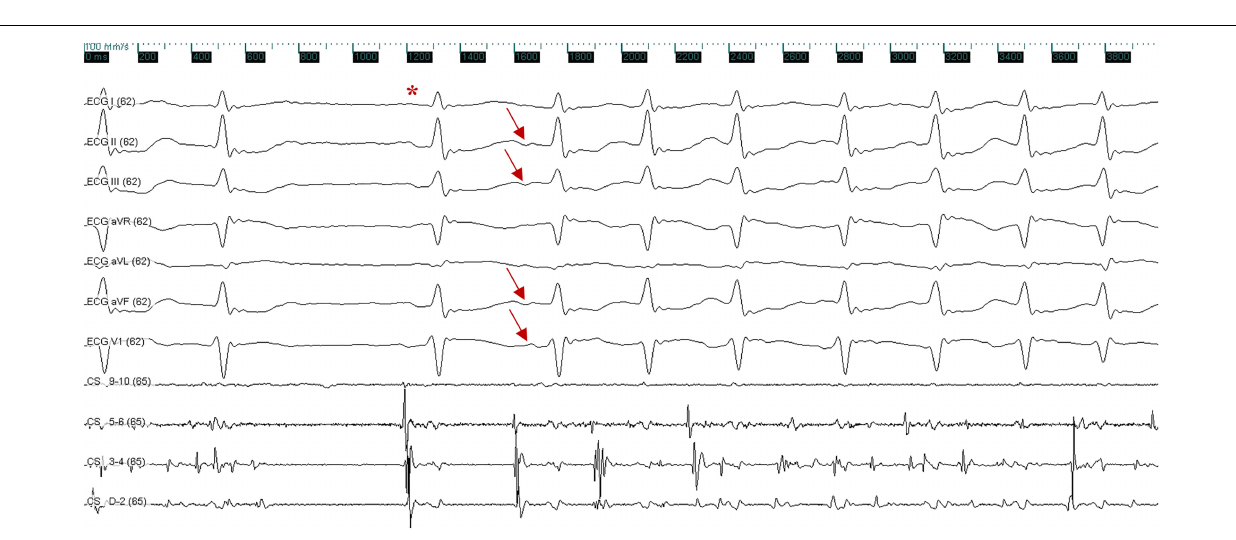
FIGURE 2 | Surface and intracardiac electrocardiogram indicate the termination of atrial fibrillation, followed by a sinus beat (red asterisk); atrial fibrillation was triggered again by a premature atrial complex, which exhibited a negative P wave in inferior leads (II, III, and aVF) and a positive P wave in lead V1 (red arrow). The ECG was recorded at a speed of 100 mm/s. X axis, time line; y axis: gain. CS, coronary sinus; ECG,